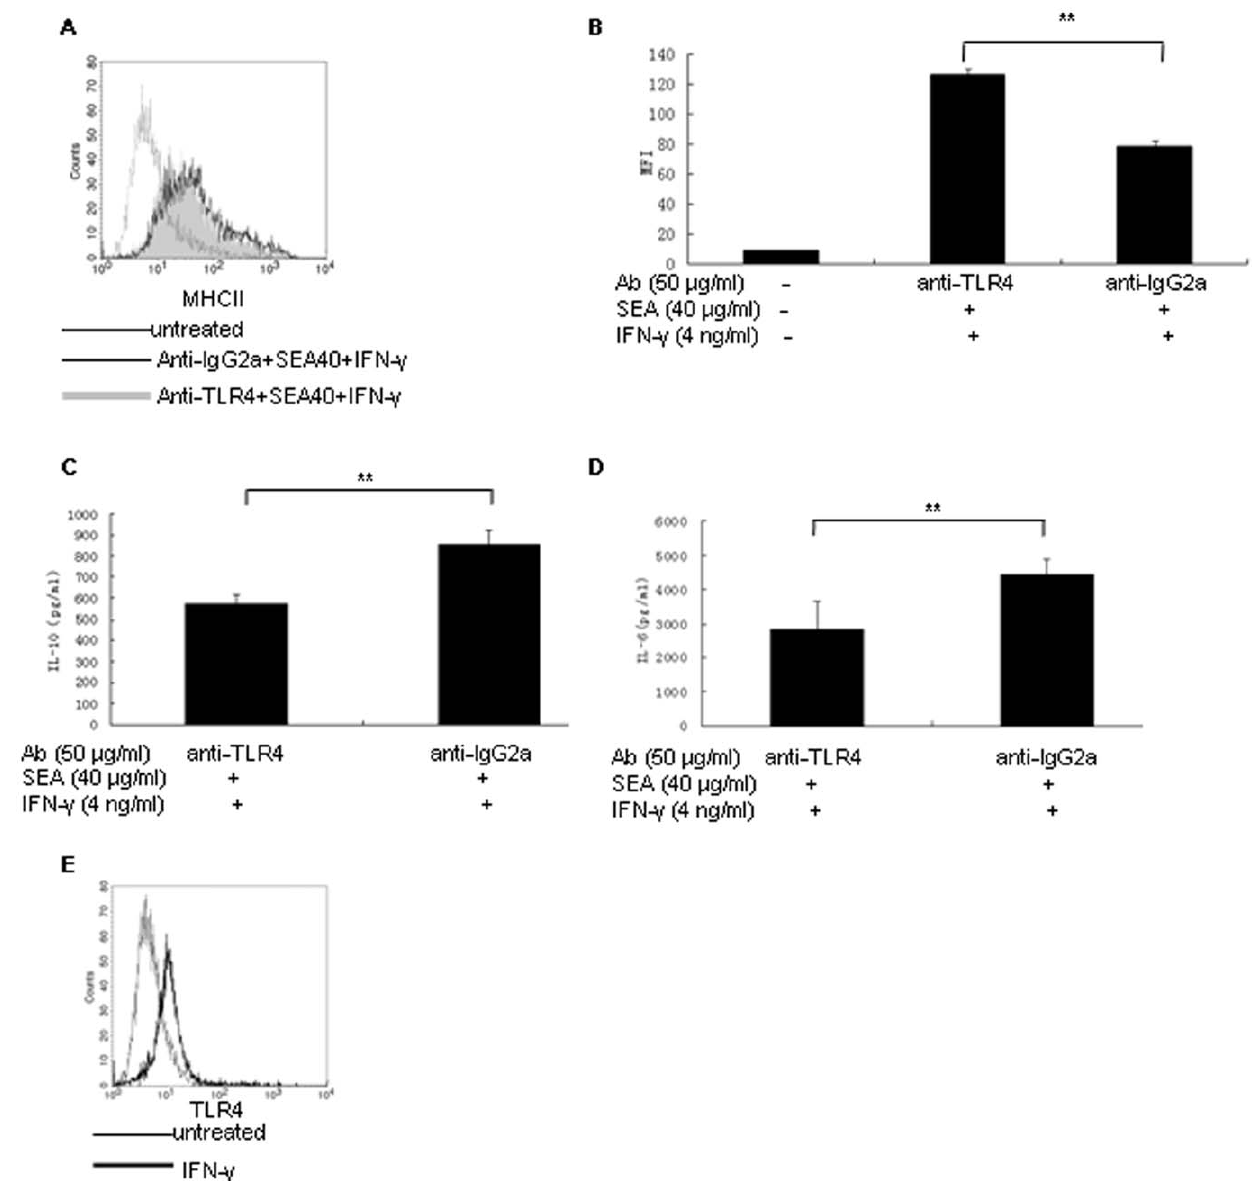
Figure 4. SEA attenuated MHC class II expression in RAW 264.7 cells through TLR4 and TLR4-induced IL-10 and IL-6. (A) Flow cytometry analysis of MHC class II expression in RAW 264.7 cells stimulated with 40 m g/ml of SEA and IFN- c simultaneously in condition of being pretreated with anti-TLR4 antibody (gray histogram), anti-IgG2a antibody (open histogram with thin line) or cultured with medium alone (untreated, open histogram with dotted line). (B) Histogram of the MFI of MHC class II expression in RAW 264.7 cells stimulated with 40 m g/ml of SEA and IFN- c simultaneously following blocked with anti-TLR4 or anti-IgG2a antibody. The cells cultured with medium alone were used as control. (C) IL-10 production tested by ELISA in supernatants of RAW 264.7 cells being blocked with anti-TLR4 antibody or anti-IgG2a antibody and then being stimulated simultaneously with SEA (40 m g/ml) and IFN- c (4 ng/ml). (D) IL-6 production tested by ELISA in supernatants of RAW 264.7 cells being blocked with anti-TLR4 antibody or anti-IgG2a antibody and then being stimulated simultaneously with SEA (40 m g/ml) and IFN- c (4 ng/ml). (** P , 0.01). (E) Flow cytometry analysis of TLR4 expression in RAW 264.7 cells stimulated with IFN- c (open histogram with bold line) or cultured with medium alone (open histogram with thin line).